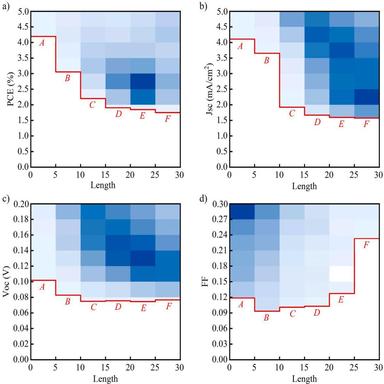
Pareto optimization search for GPSR-generated formulas. The Y-axis represents the score (Scoring metrics use RMSE) of the formula and the X-axis represents the length of the formula. The colour shade represents the density of generated formulas in that scoring region. a) prediction scores for PCE, b) prediction score for Jsc, c) prediction score for Voc, and d) prediction score for FF. (For interpretation of the references to colour in this figure legend, the reader is referred to the Web version of this ar